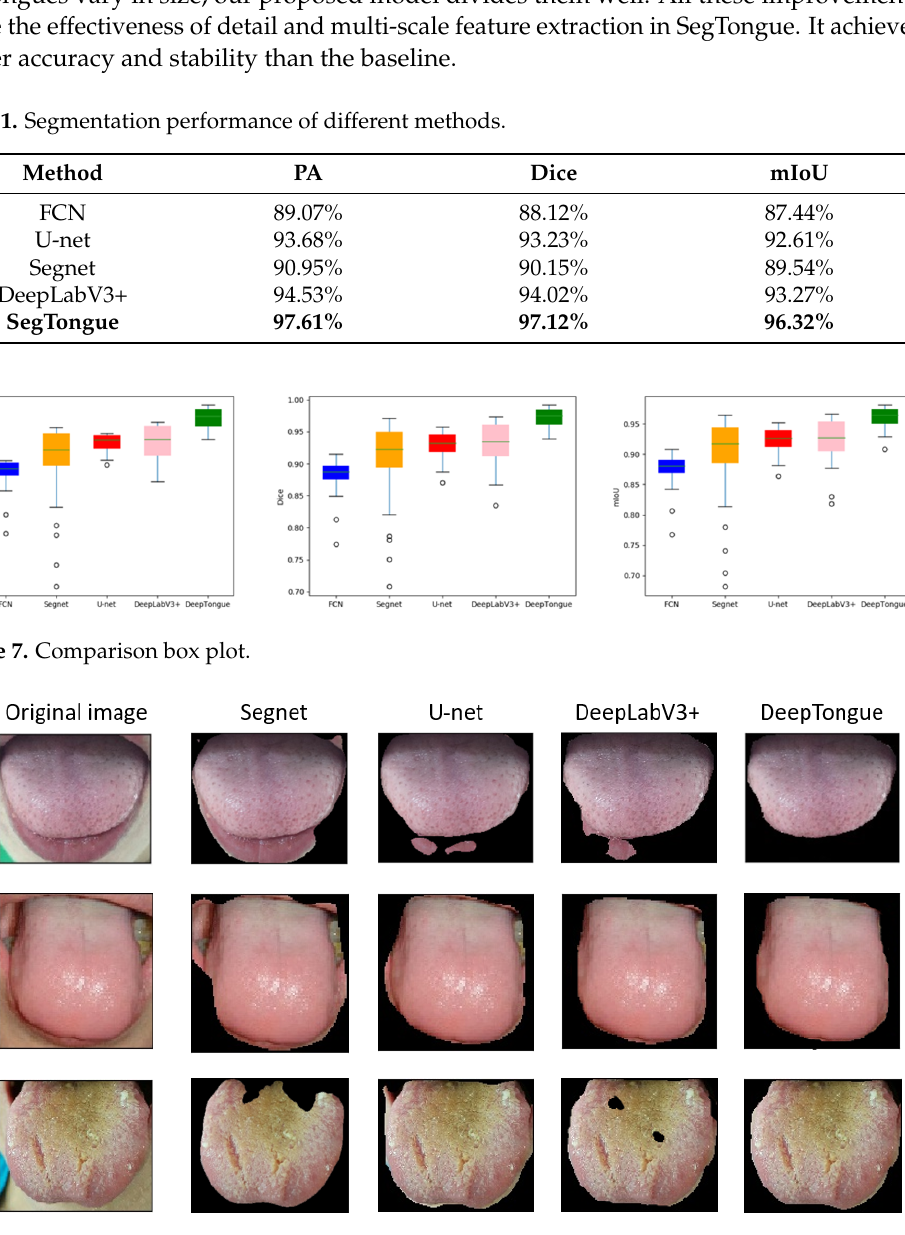
Figure 7. Comparison box plot.